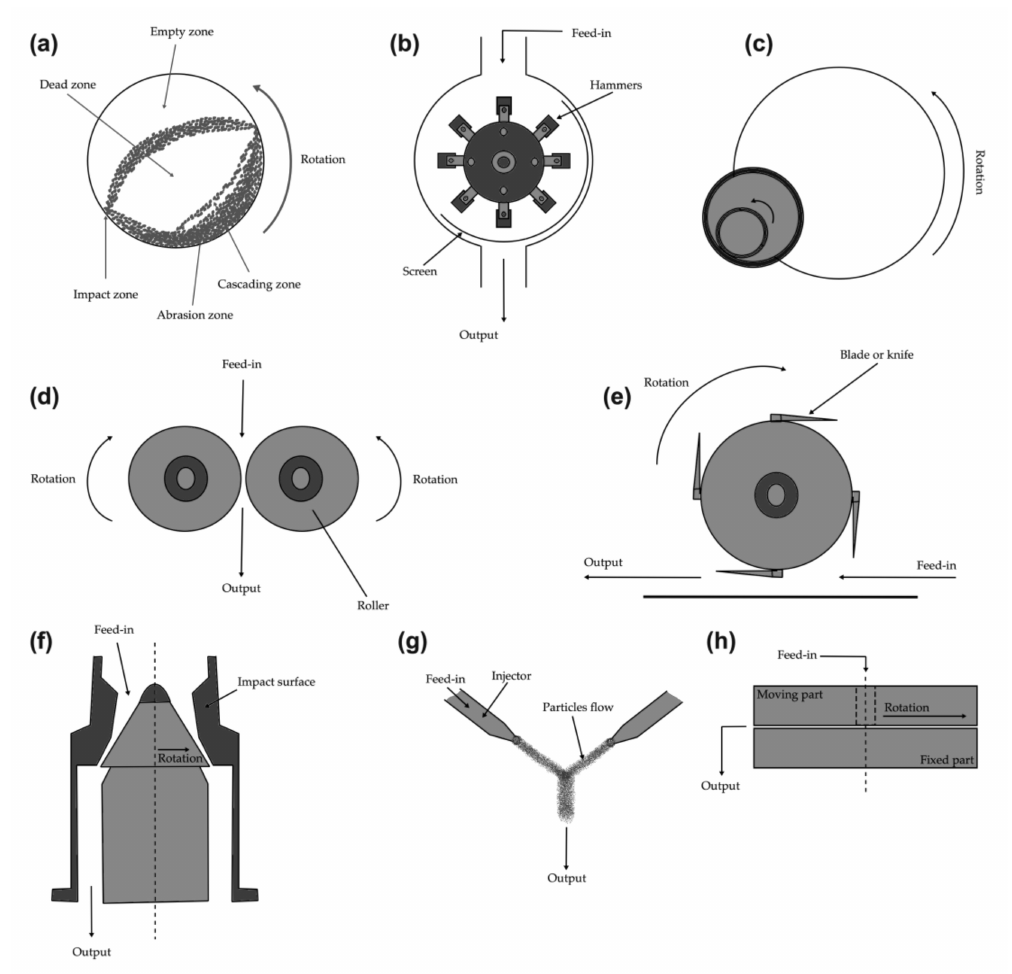
Figure 1. Schematic representation of the operating model of each of the mills described above: ( a ) Tumbling mill; ( b ) Hammer mill; ( c ) Disc mill; ( d ) High Pressure Grinding Rollers; ( e ) Blade breakers; ( f ) Universal mill; ( g ) Jet mill; and ( h ) Grinding